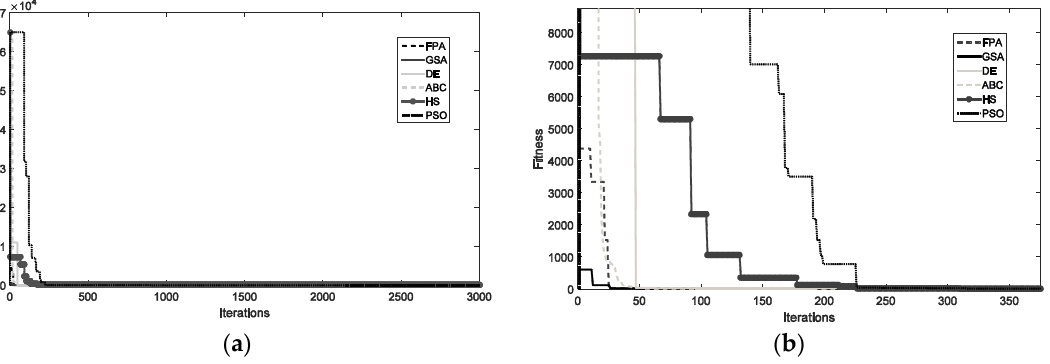
Figure 3. Evolution of the objective function values for FPA, GSA, DE, HS, ABC, and PSO. ( a ) Graphs over 3000 iterations and ( b ) zoom over 400 iterations.